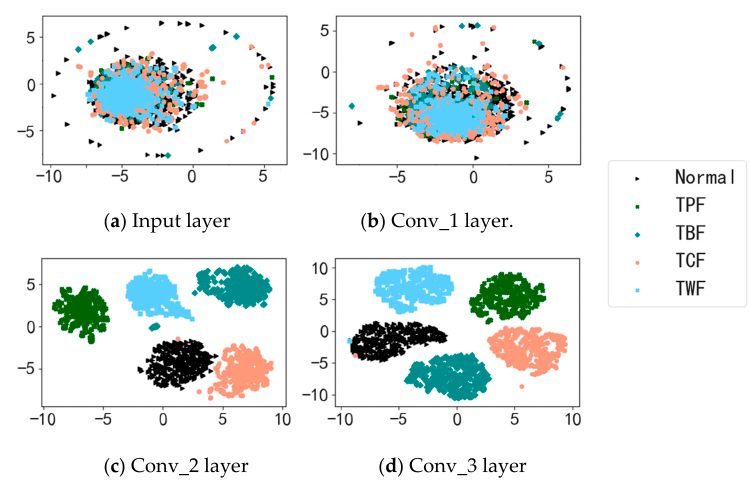
Figure 16. Feature learning visualization with t-SNE.